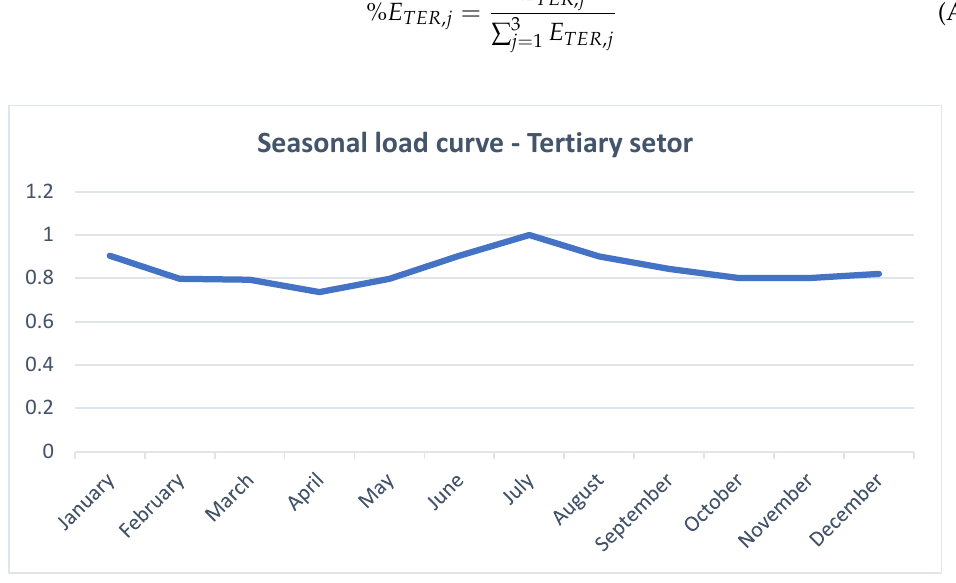
Figure A3. Seasonal load curve used for the tertiary sector (based on [36]).